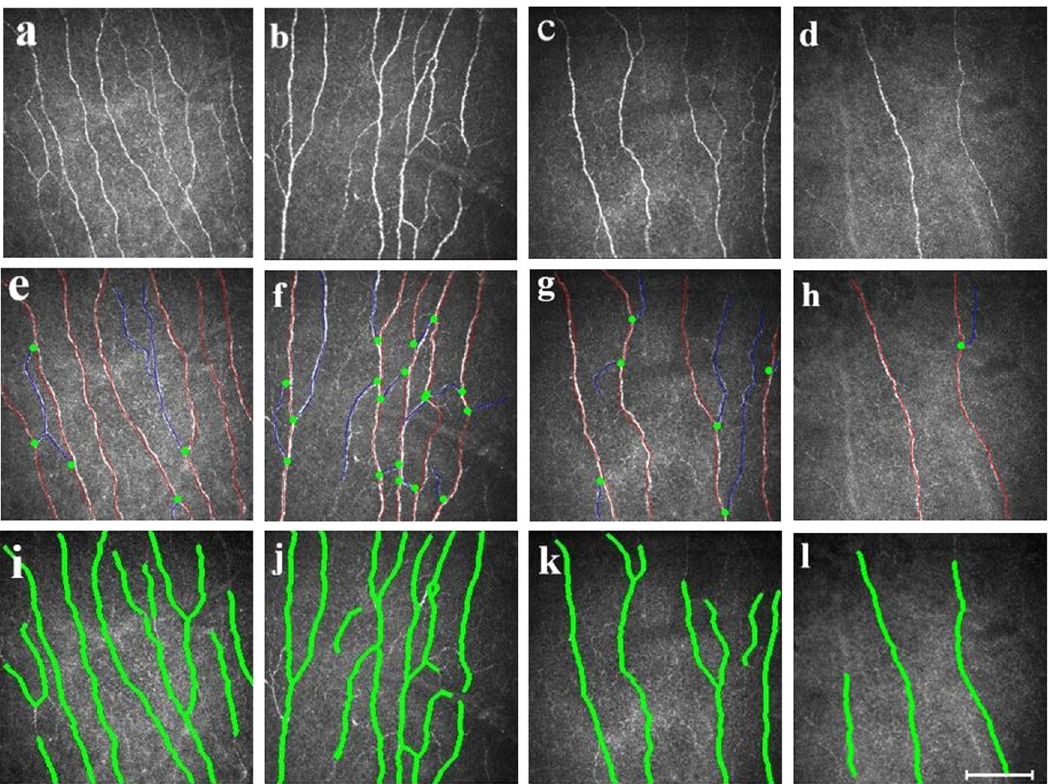
Fig. 2 Representative CCM images in healthy controls, PD-CN, PD-MCI, and PDD. The corneal nerve plexus is beaded, linear homogeneous and highly re fl ective ( a – d ). Nerve fi ber trunks are highlighted in red; branch origins are represented by the green dots ( e – h ) and corneal nerve fi ber length is shown in green line ( i – l ). Images e – h were analyzed with the manual software (CCMetrics) and images i – l were marked with the automated version (ACCMetrics). PD-CN patients showed decreased CNFD and increased CNBD compared to the control group. PD-MCI and PDD patients showed a progressive reduction in CNFD, CNBD, and CNFL. Abbreviations: CCM corneal confocal microscopy, PD-CN Parkinson ’ s disease with cognitively normal, PD-MCI Parkinson ’ s disease with mild cognitive impairment, PDD Parkinson ’ s disease dementia, CNFD